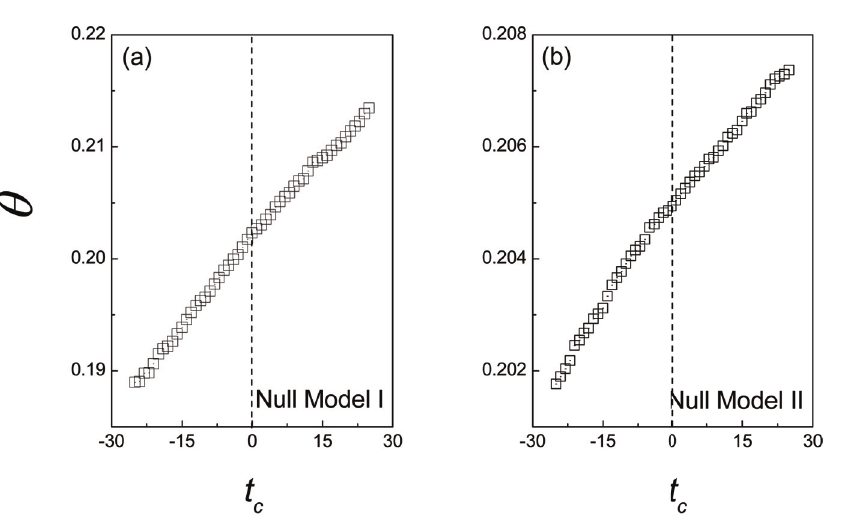
Fig 5. The dynamics of the taste similarity θ for Null models. The design of the null models have been introduced in the section Dynamics of common interest overlaps . (a) and (b) The dynamics of the taste similarity θ for Null model I and Null model II, respectively. In both Null models, the taste similarity θ linearly increases as the time t c increases, which is totally different with the result shown by the empirical data. Therefore, the users ’ real tastes can not be reflected by their random online temporal